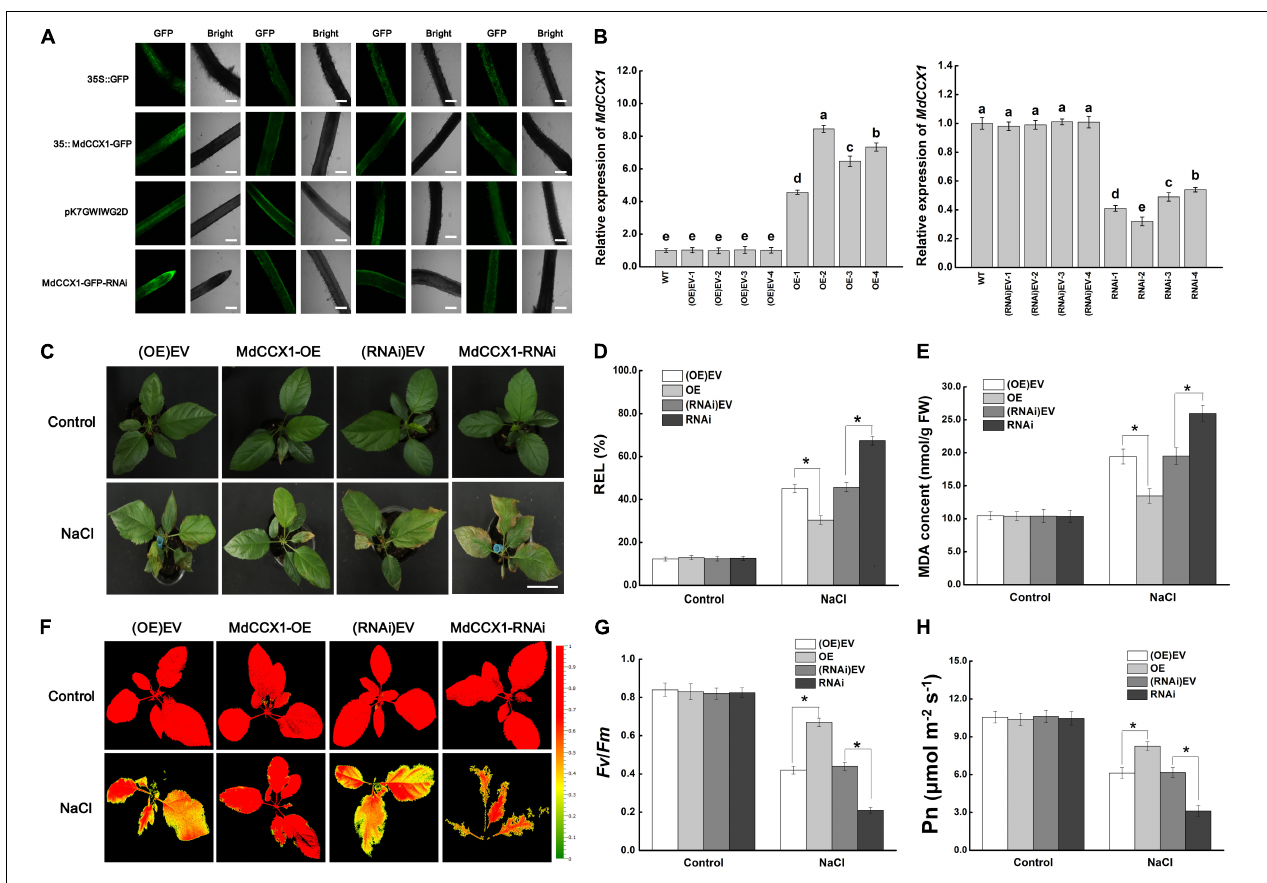
FIGURE 8 | Phenotypic analysis of transgenic apple plants under 150 mM NaCl treatment. (A) Representative images of GFP fluorescence of transgenic apple roots. OE-EV and RNAi-EV represent roots transformed with the empty vector pCambia2300 or pK7GWIWG2D. Scale bars, 300 µ m. (B) Identification of MdCCX1 expression in transgenic apple roots. (C) Typical images of phenotypes treated with 0 or 150 mM NaCl for 7 d. Scale bars, 4 cm. (D) Relative electrolyte leakage. (E) MDA content. Representative chlorophyll fluorescence images (F) and Fv/Fm ratios (G) of different transgenic lines under normal and NaCl stress conditions. The false colors in the images indicate the Fv/Fm ratios ranging from 0 (black) to 1.0 (red). (H) Net photosynthetic rate (Pn). The values of each index are the average values from all lines in transgenic plants of the same type for (D) , (E) , (G) , and (H) . Values are means of 20 replicates ± SD. * in each panel indicates values that are significantly different from the corresponding control lines at p < 0.05, using Student’s t-test